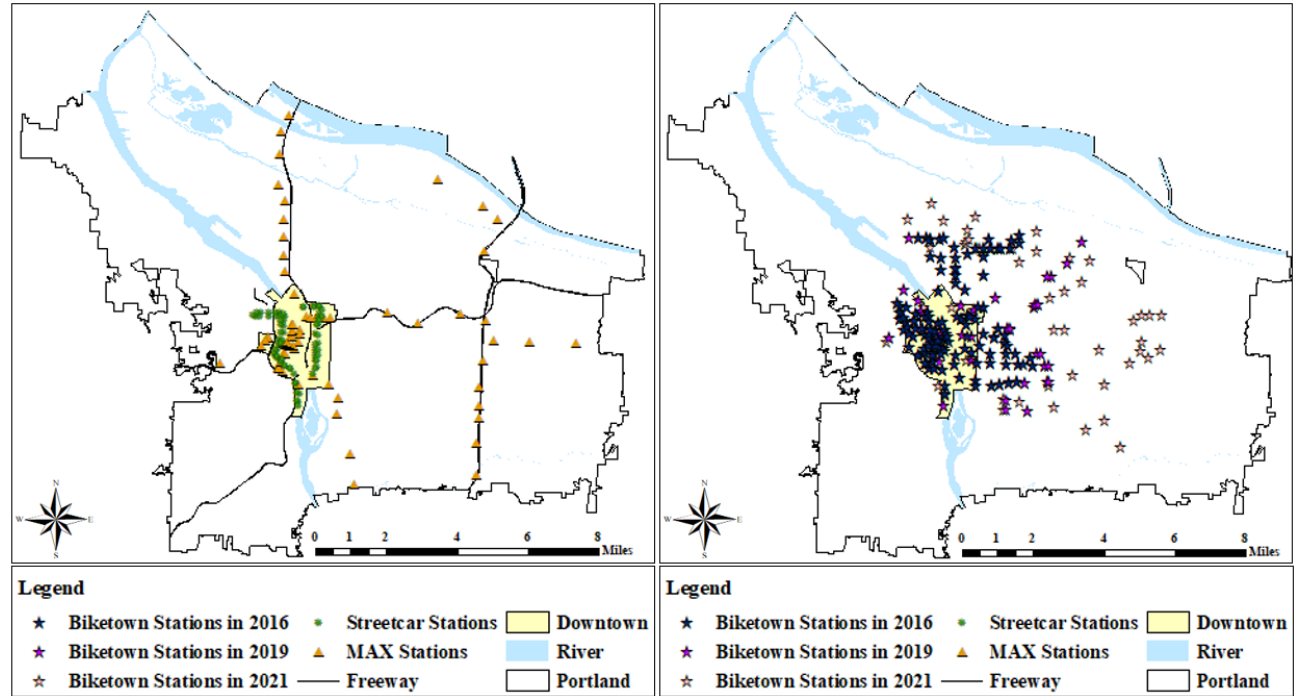
Figure 2. Descriptions of the study area (Data source: Regional Land Information System and Bureau of Transportation Statistics) (accessed on 15 April 2022).